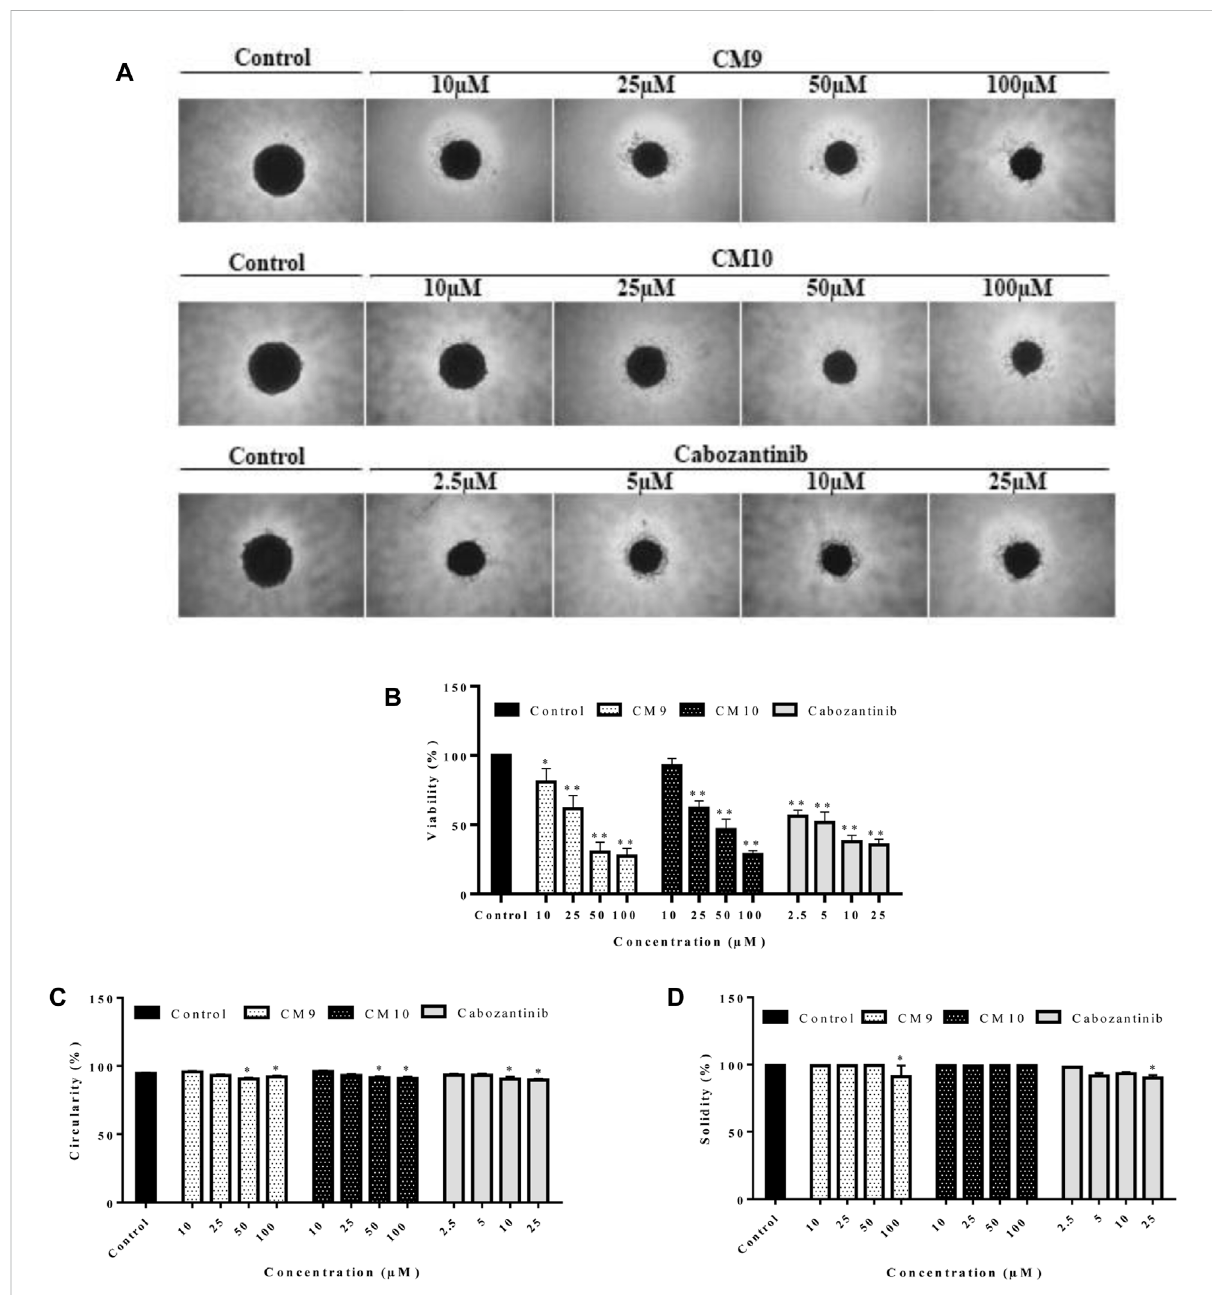
FIGURE 4 Growth inhibitory effects of synthesized compounds against cancer cells grown in three-dimensional spheroid cultures. Spheroids of EBC-1 cells were formed by agarose-based liquid overlay technique in 96-well plates. (A) Representative images of spheroids treated with CM9 and CM10 at 10, 25, 50, and 100 µM are shown. The images were captured with Nikon NIS-Elements imaging software. (B) Growth inhibitory effects of compounds against EBC-1 spheroids was measured by acid phosphatase (APH) assay. (C) Circularity and (D) solidity of 3D spheroids after drug treatment were measured by ImageJ software. Cabozantinib was also tested as a positive control. Data are presented as mean ± S.E.M. of 3- 6 independent experiments. The difference with control was statistically signi fi cant at * ( p < 0.05), ** ( p <